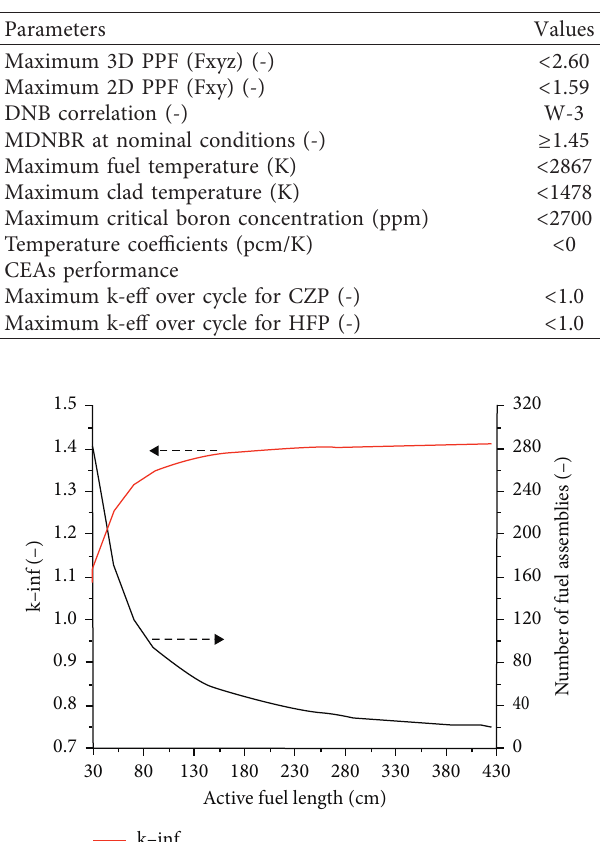
Table 2: The design